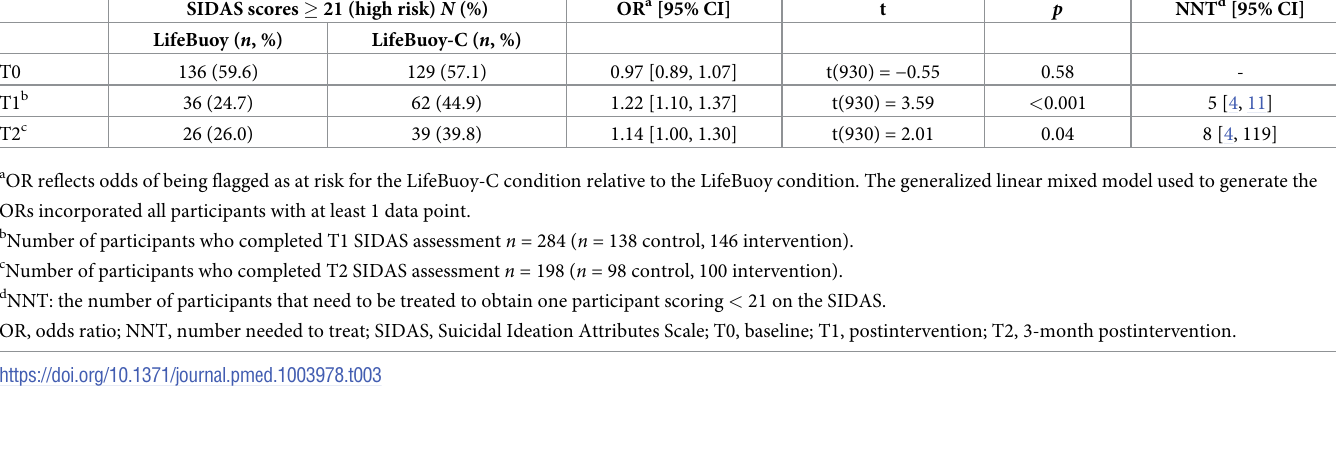
Table 3. Proportion of participants at high risk for suicidal behavior at T0, T1, and T2. SIDAS scores � 21 (high risk) N (%) OR a [95% CI] t p NNT d [95% CI] LifeBuoy ( n , %) LifeBuoy-C ( n , %) T0 136 (59.6) 129 (57.1) 0.97 [0.89, 1.07] t(930) = − 0.55 0.58 - T1 b 36 (24.7) 62 (44.9)